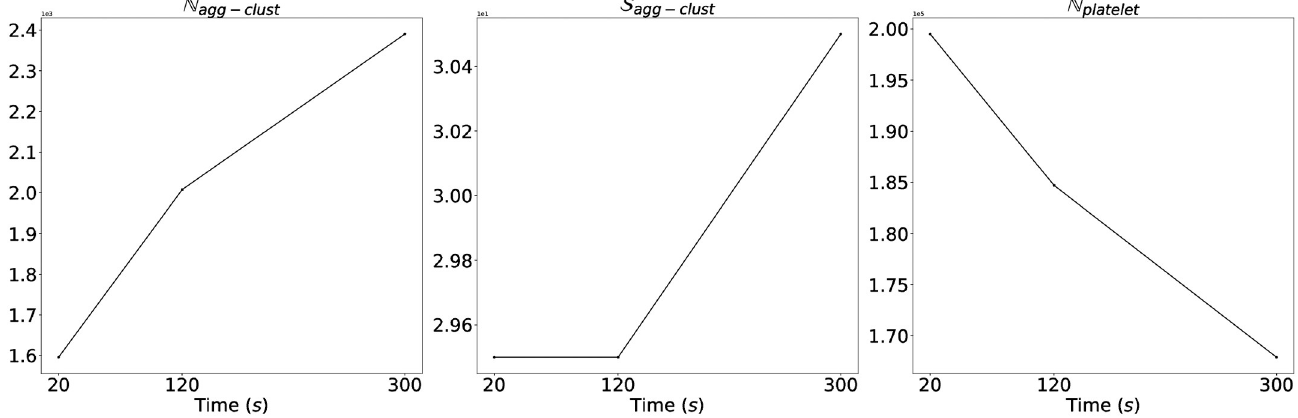
ð t Þ , S ð t Þ and agg (cid:0) clust agg (cid:0) clust